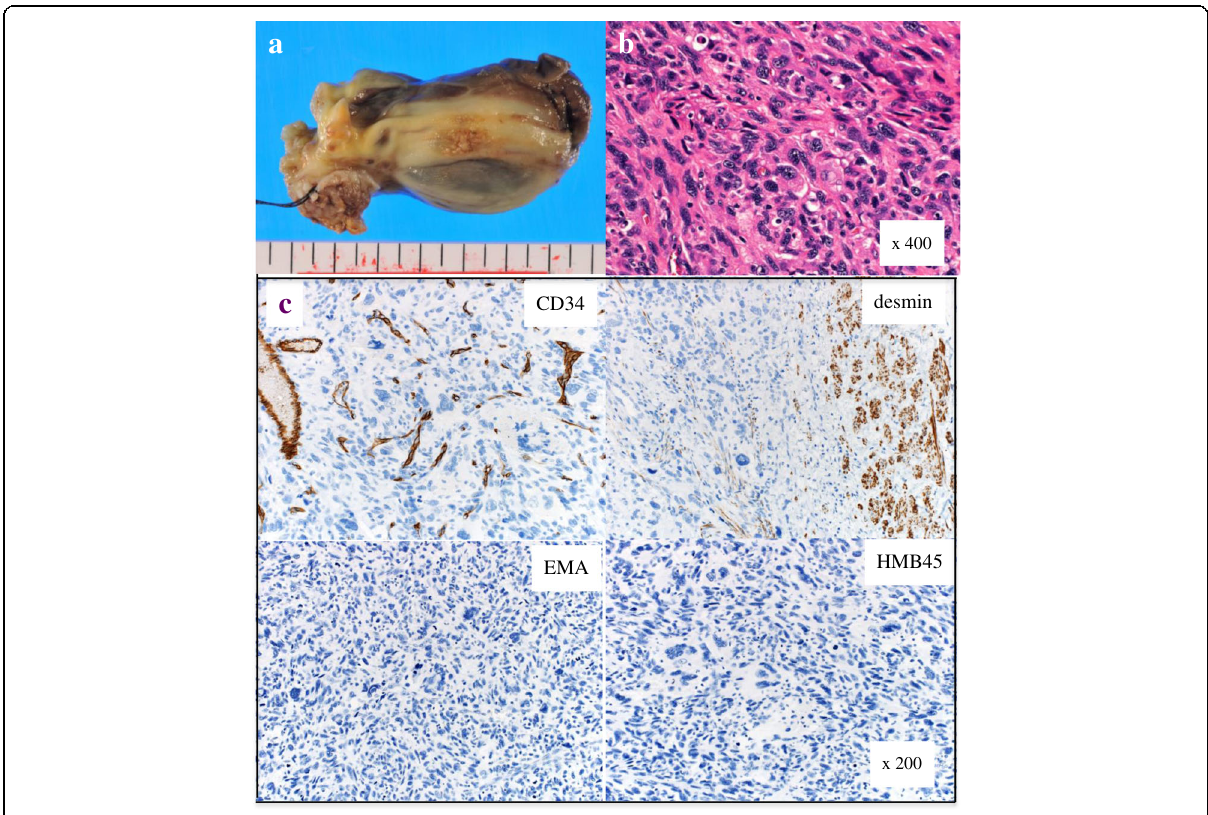
Fig. 3 Excised cardiac tumor. a The tumor occupied the left atrium cavity (75 × 37 × 30 mm). b Pathological findings of the tumor showed undifferentiated high-grade pleomorphic sarcoma with an irregular spindle or multi-nucleated giant cells (hematoxylin and eosin staining). c Immunohistochemical staining. Tumor cells were negative for CD34, desmin, EMA, and